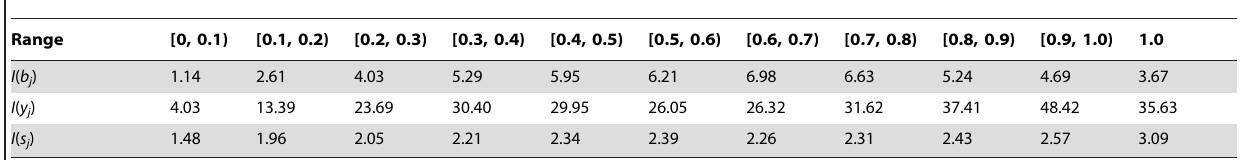
Table 2. The intensity discriminability of b-ions ( I ( b j ) ), y-ions ( I ( y j ) ) and the six types (b, b-H 2 O, b-NH 3 , y, y-H 2 O and y-NH 3 ) of theoretical ions ( I ( s j ) ).